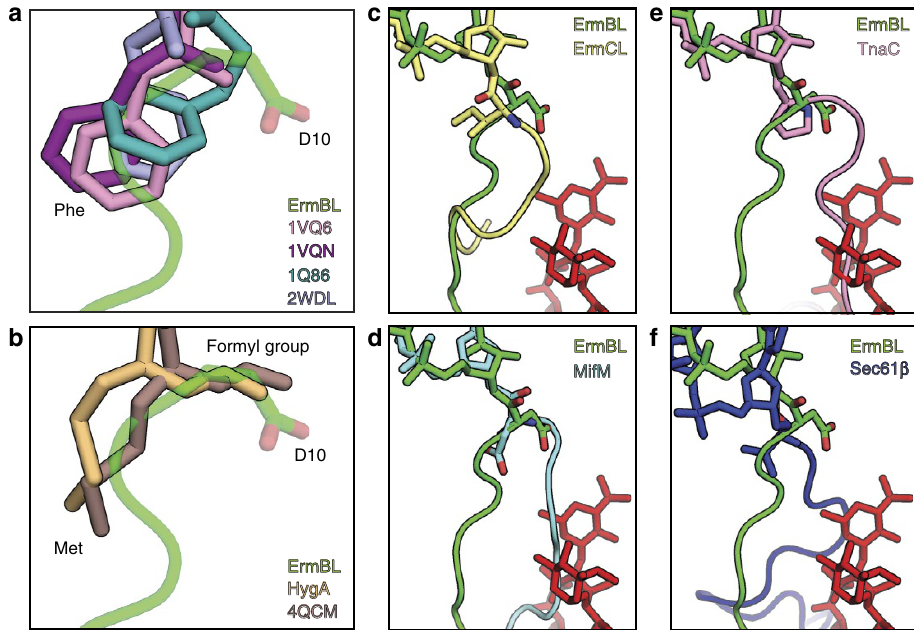
Figure 4 | Rotation of the C-terminal amino acid and an alternate path of ErmBL. ( a , b ) Orientation of ErmBL D10 compared with ( a ) CC-Phe-caproic- acid-biotin (CC-pcb) tRNA analogues (pink, PDB1VQ6; purple, PDB1VQN 30 ; and teal, PDB1Q86 (ref. 74)), and Phe-tRNA (blue, PDB2WDL 33 ) and with ( b ) T. thermophilus 70S ribosomes bearing fMet-tRNA (brown, PDB4QCM 32 and yellow, PDB 4Z3R 75 ). ( c – f ) Alternate path of ErmBL (green) compared with ( c ) that of ErmCL (yellow, PDB 3J7Z 13 ), ( d ) MifM (light blue, PDB3J9W 18 ), ( e ) TnaC (pink, PDB4UY8 (ref. 14)) and ( f ) Sec61 b (dark blue, PDB 3J92 (ref. 20)) in relation to the position of ERY (red).